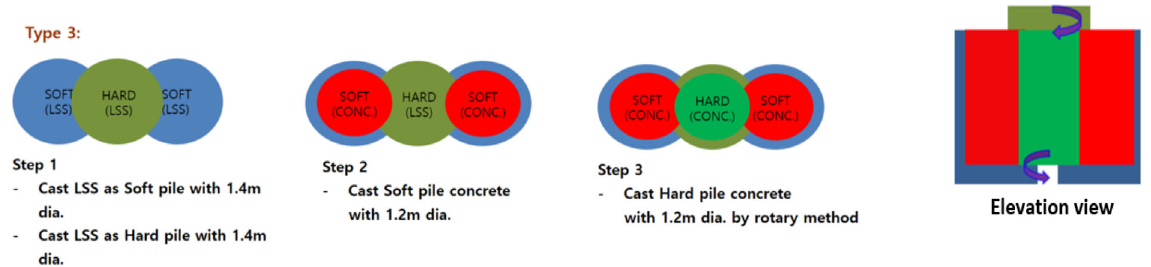
Fig. 9 Method for construction of type 3 SBPs (plan